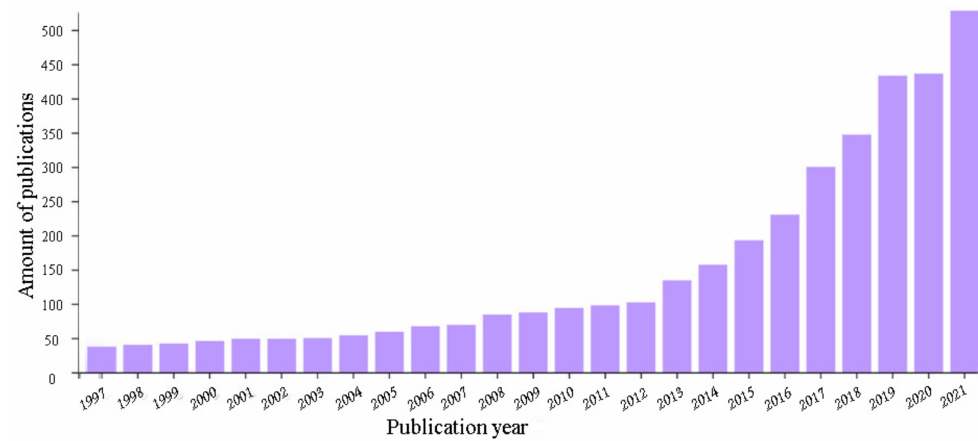
Figure 1. The number of publications in the field of membrane separation of oil-water emulsions in the Web of Science collection over the past 25 years (search was performed using the keywords “membrane + oil water